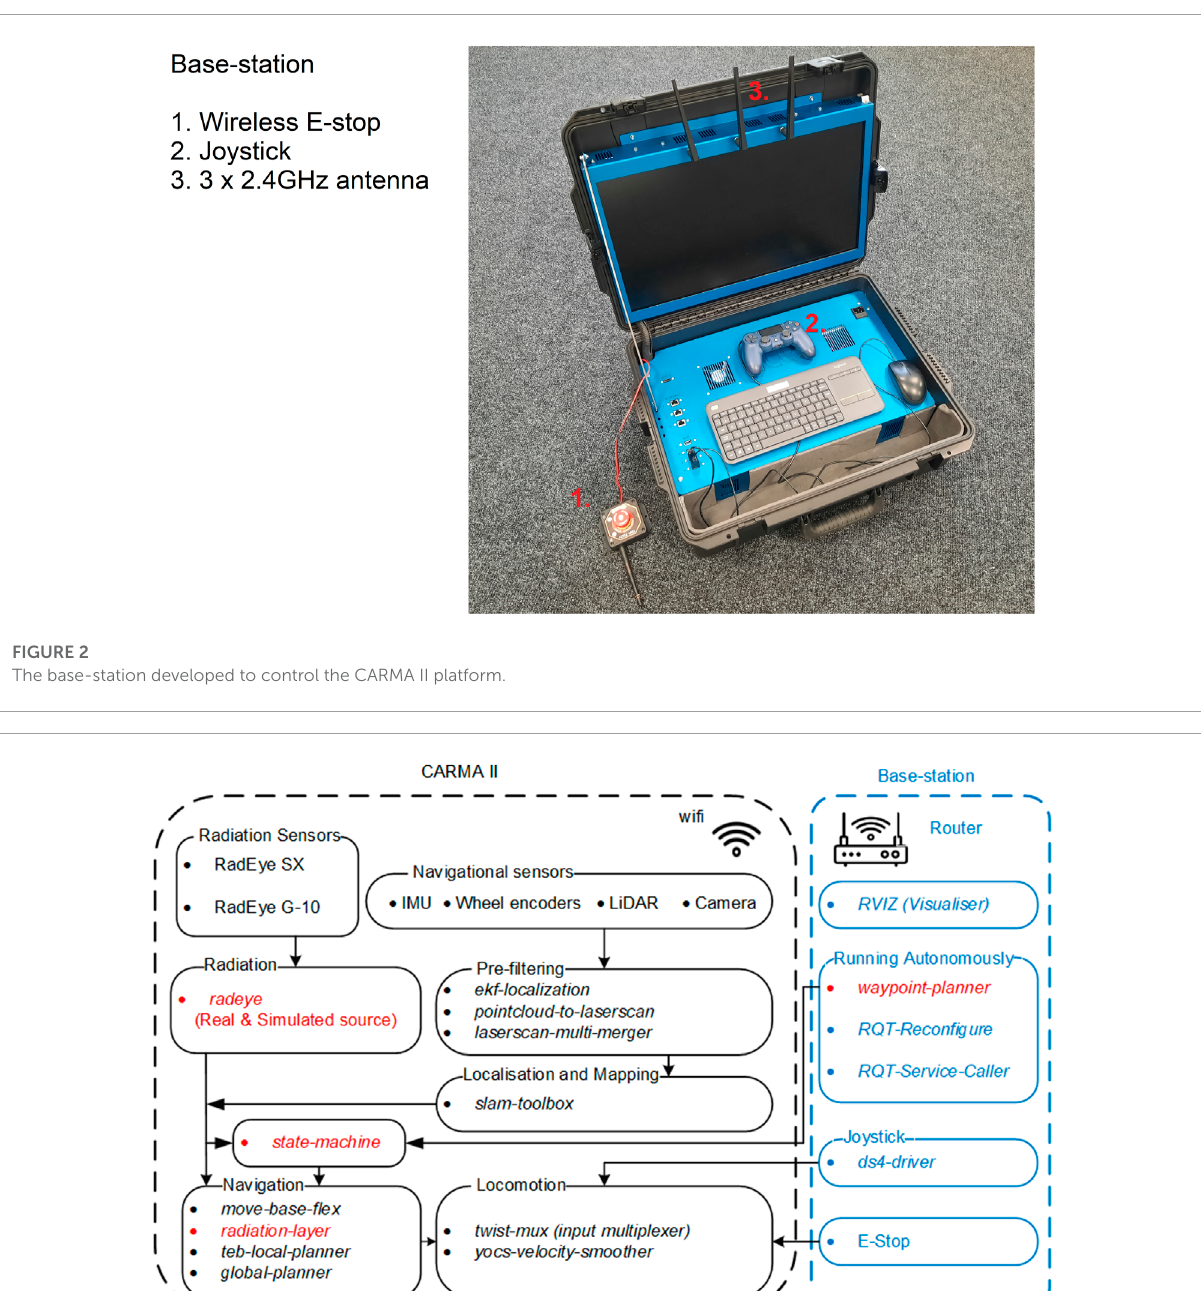
In manual mode, CARMA II is driven using a joystick controller as shown in Figure 2 . Manual mode is generally used for moving the robot around for convenience, or to generate the map that is used by the on-board autonomous algorithms. In both autonomous and manual modes, the physical map is generated by slam-toolbox 1